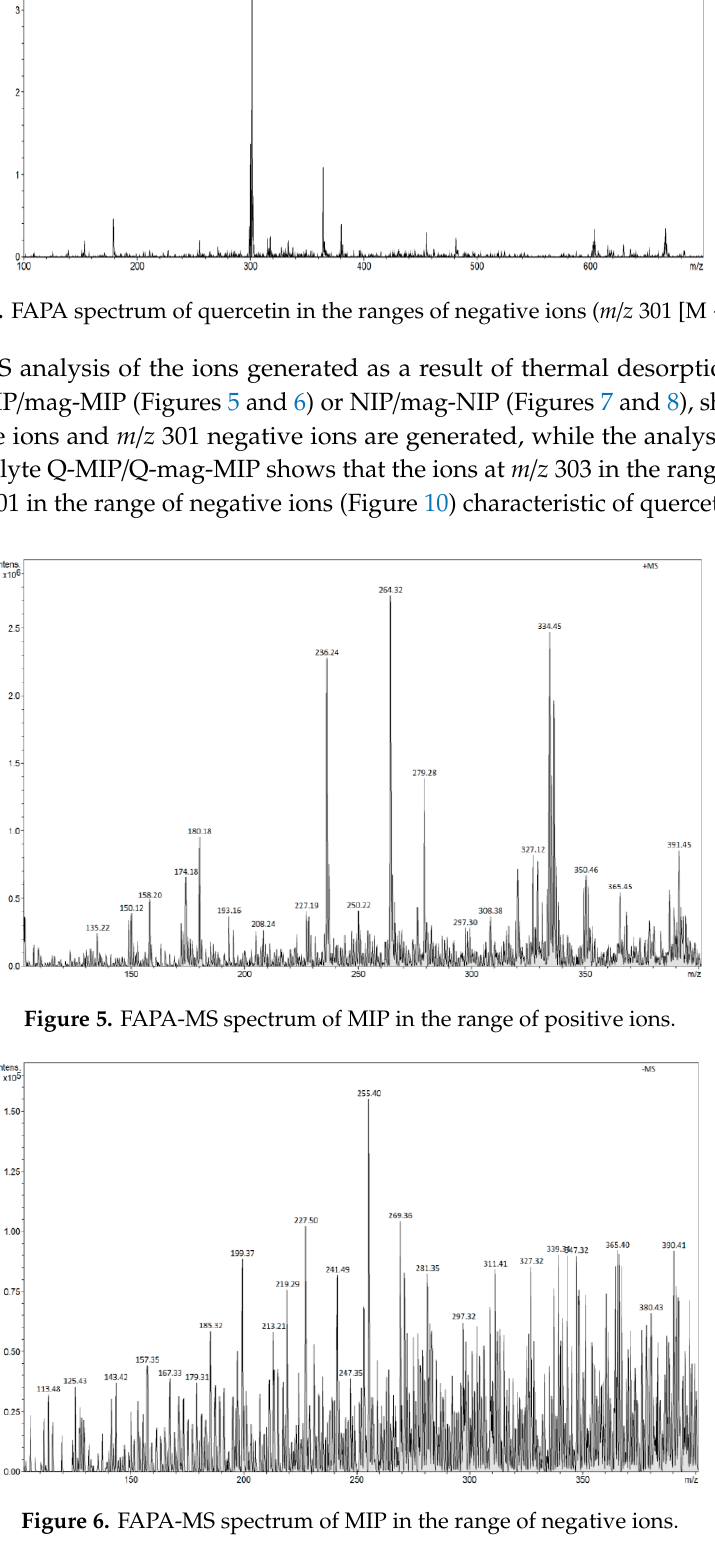
Figure 7. FAPA-MS spectrum of NIP in the range of positive ions. Figure 8. FAPA-MS spectrum of NIP in the range of negative ions.